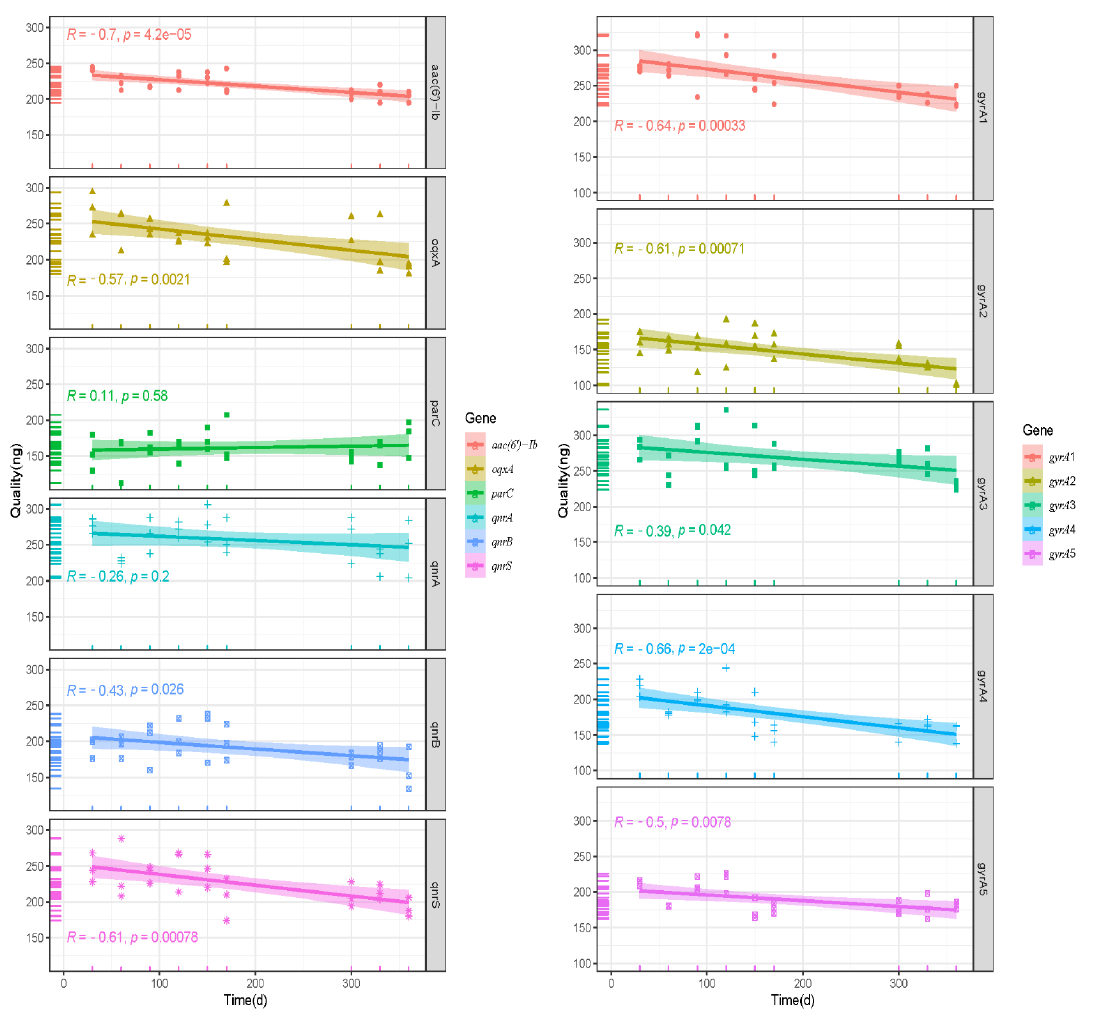
Figure 8. Long−term stability of the quantity of plasmid DNA reference materials stored at −20 °C. Note: “R” represents the correlation coefficient, “ p ” represents the significant difference, and the shadow represents the 95% confidence interval.